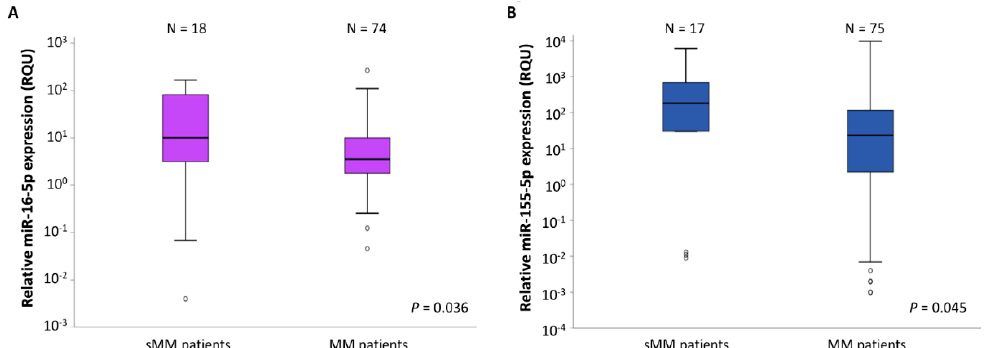
Figure 2. Boxplots showing the relative expression of miR-16-5p ( A ) and miR-155-5p ( B ) in CD138+ plasma cells of smoldering multiple myeloma (sMM) and multiple myeloma (MM) patients. The bold line inside each box represents the median value, while the lower and upper borders of the box represent the 25th (Q1) and 75th (Q3) percentiles, respectively; the area within the box represents the interquartile range (IQR). The lower and upper whiskers show values equal to 𝑄1 − 1.5 ∗ 𝐼𝑄𝑅 and 𝑄3 + 1.5 ∗ 𝐼𝑄𝑅 , respectively. The circles outside the boxes indicate outliers. The scale of the vertical axis is logarithmic. Table 1. Distribution of miRNA expression in CD138+ plasma cells of patients with smoldering MM and MM, as well as in CD138+ plasma cells of MM patient subgroups.